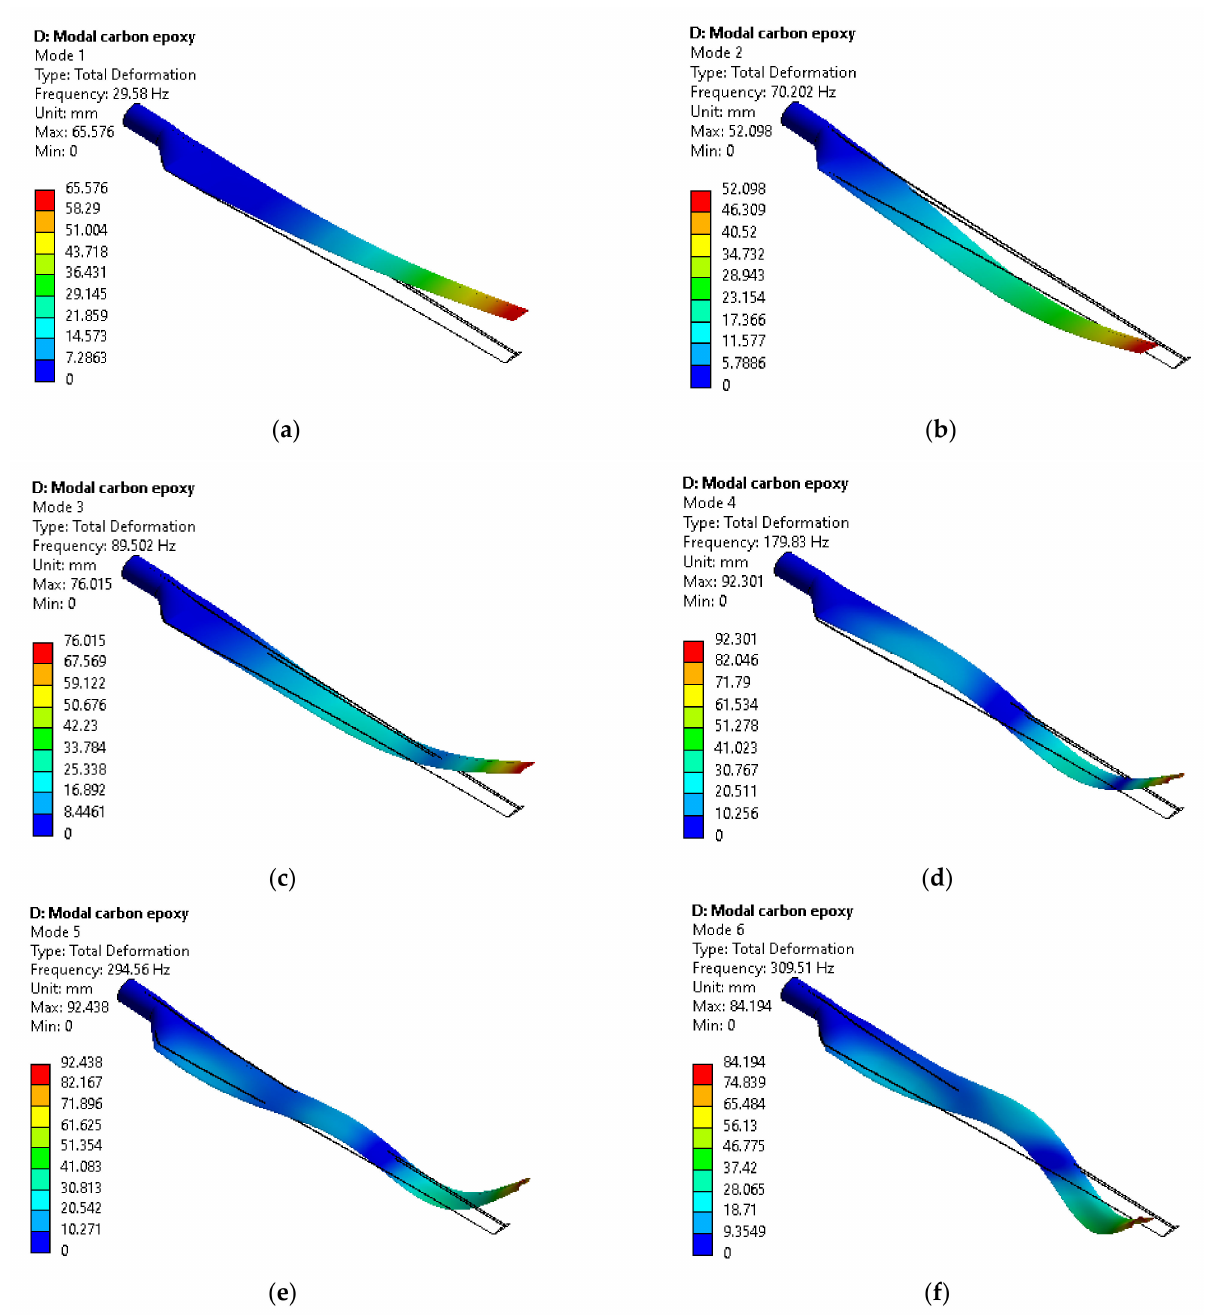
Figure 15. The first 6th mode shape of Carbon/Epoxy material. ( a ) 1st mode. ( b ) 2nd mode. ( c ) 3rd mode. ( d ) 4th mode. ( e ) 5th mode. ( f ) 6th